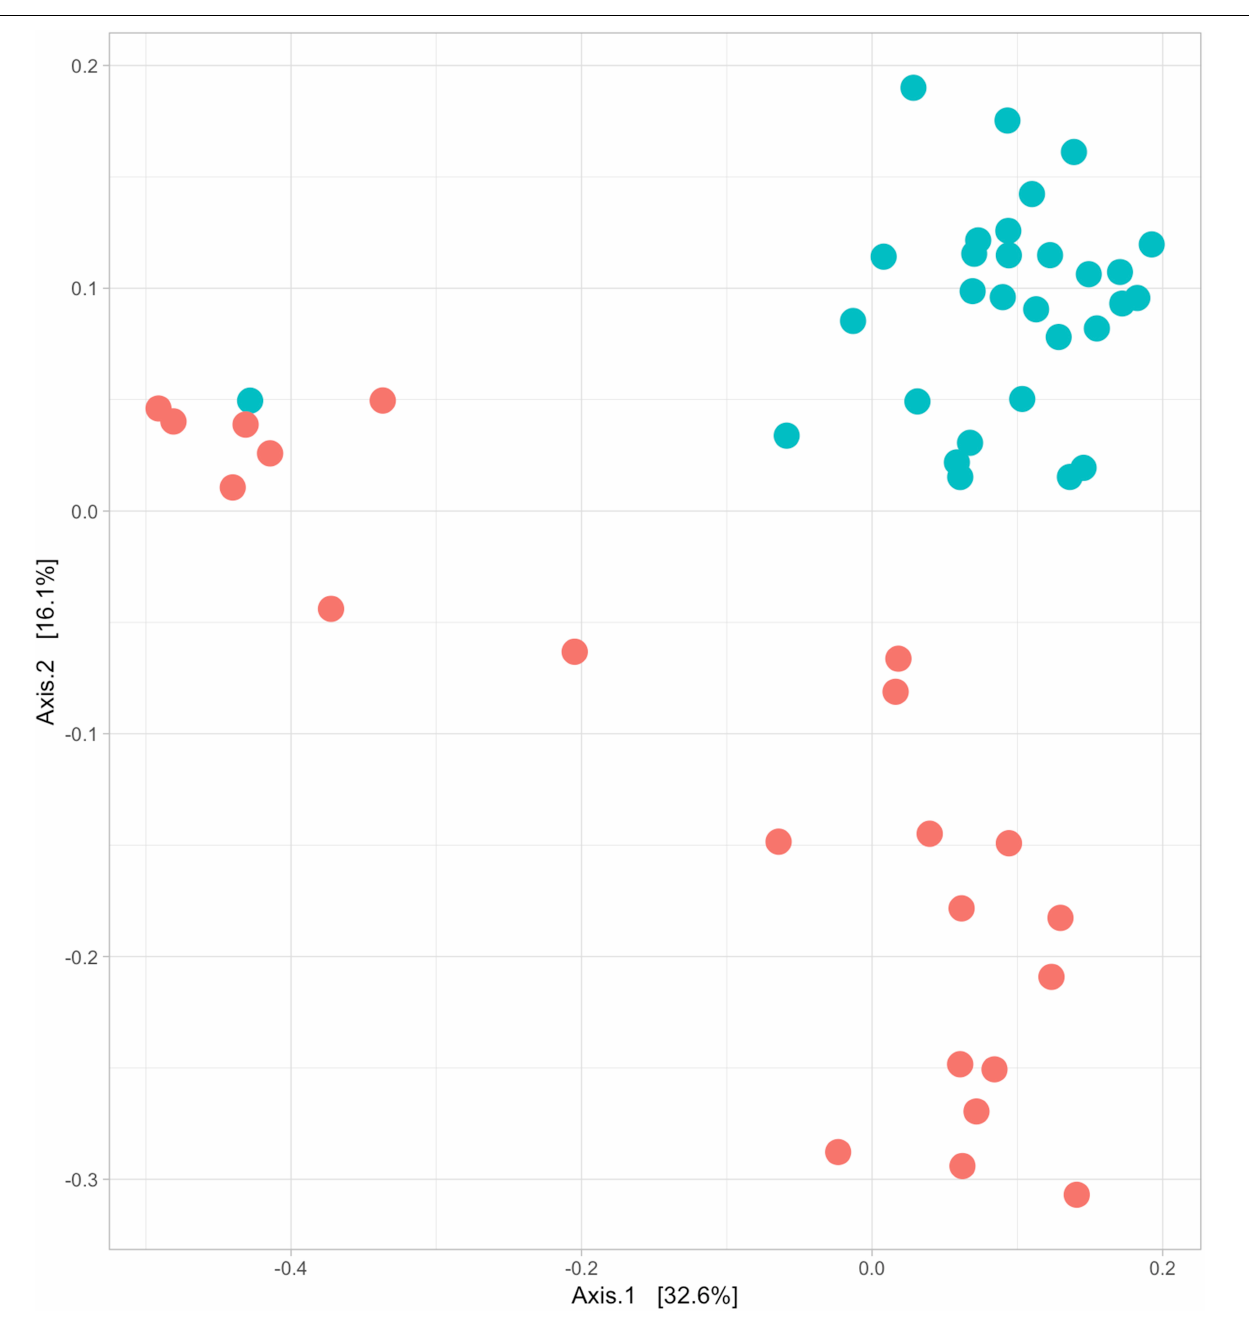
FIGURE 3 | Egyptian and Griffon vultures exhibit different bacterial communities. Beta diversity; principal coordinate analysis visualizing the clustering of bacterial communities of 52 fecal samples from Egyptian (six individuals, n = 22 samples; red) and Griffon vultures (seven individuals, n = 30 samples; blue) based on unweighted UniFrac dissimilarity matrix. Vulture species exhibited minor overlap (ANOSIM; R = 0.545, P =